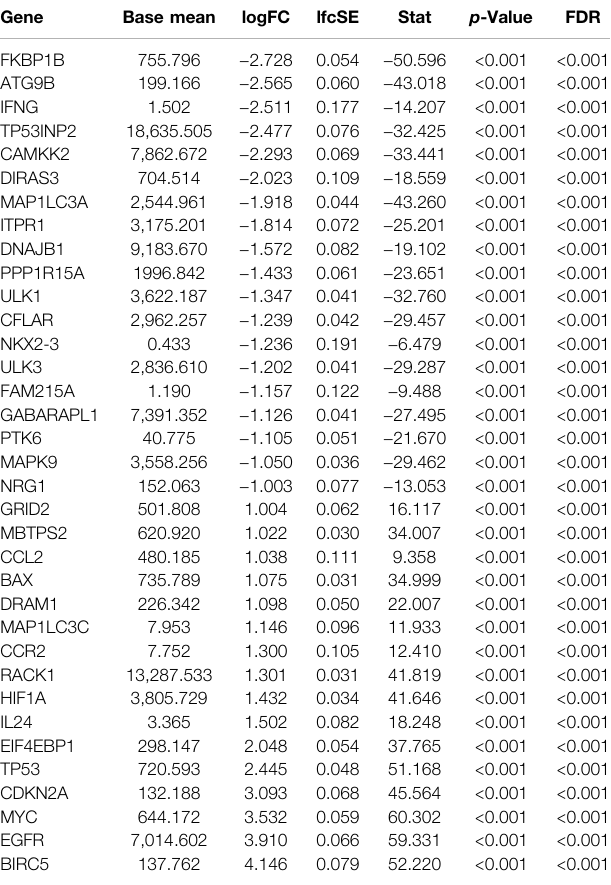
TABLE 1 | SD-ARGs expression levels in LGG and normal